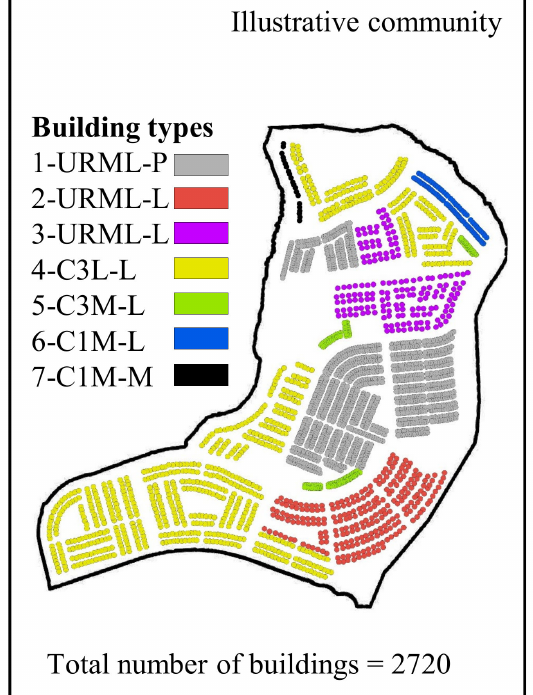
Figure 6. Illustrative community consisting of building